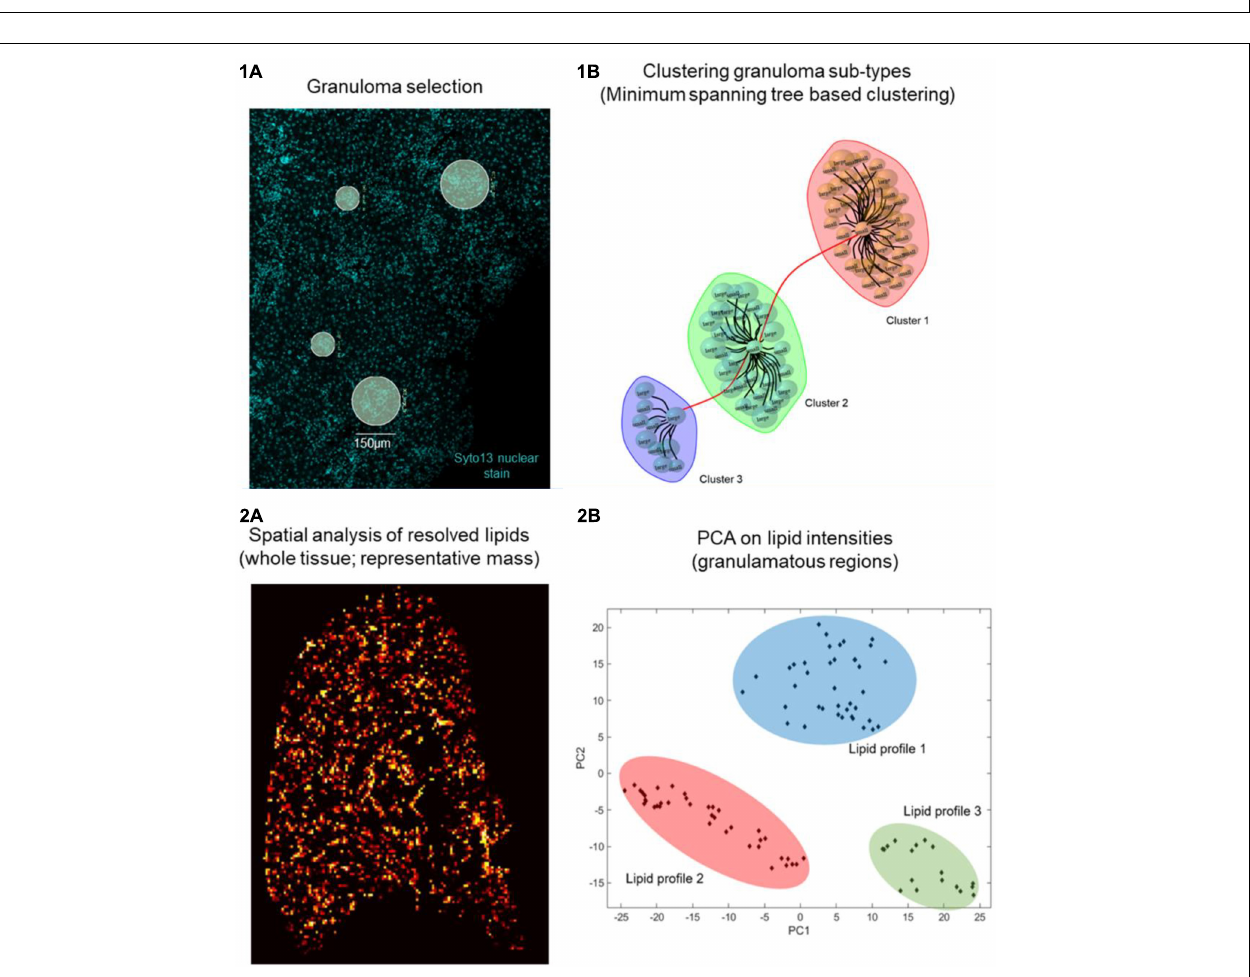
FIGURE 2 | Preliminary data on Leishmania granuloma. Day 28 p.i. L. donovani infected C57BL/6 mice liver sections ( n = 5) were 1A stained with SYTO 13 nuclear dye and Nanostring Immune Cell Profiling Core and IO Drug Target Modules (protein panel, 26 oligo labeled antibodies). Eighty granulomas (75 or 150 µ diameter) were selected based on nuclear dye on a Digital Spatial Profiler (DSP, Nanostring). UV light cleaved ROIs from individual granulomas were collected in a 96 well plate, hybridized, and counted on an nCounter system (1B) . Distinct granuloma clusters as calculated based on edge betweenness of a minimum spanning tree representation of a granuloma weighted (Pearson’s correlation) graph object. (2A) Day 14 L. donovani infected mouse liver sections ( n = 5) were analyzed by MSI. (2B) Principal component analysis (PCA) is used as an unsupervised approach to show variance in spatial distribution of all lipid masses from every pixel across